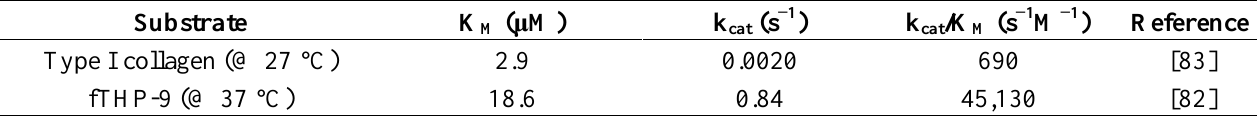
Table 3. Kinetic parameters for substrate hydrolysis by soluble